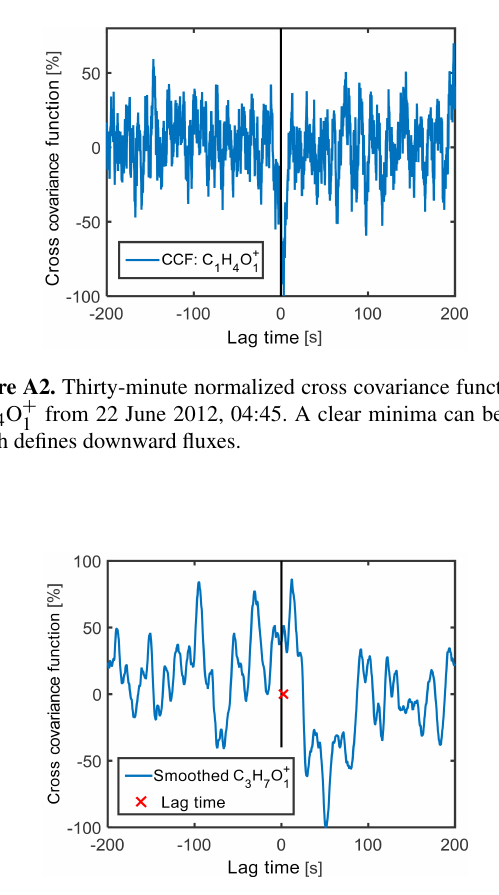
. The red cross 1